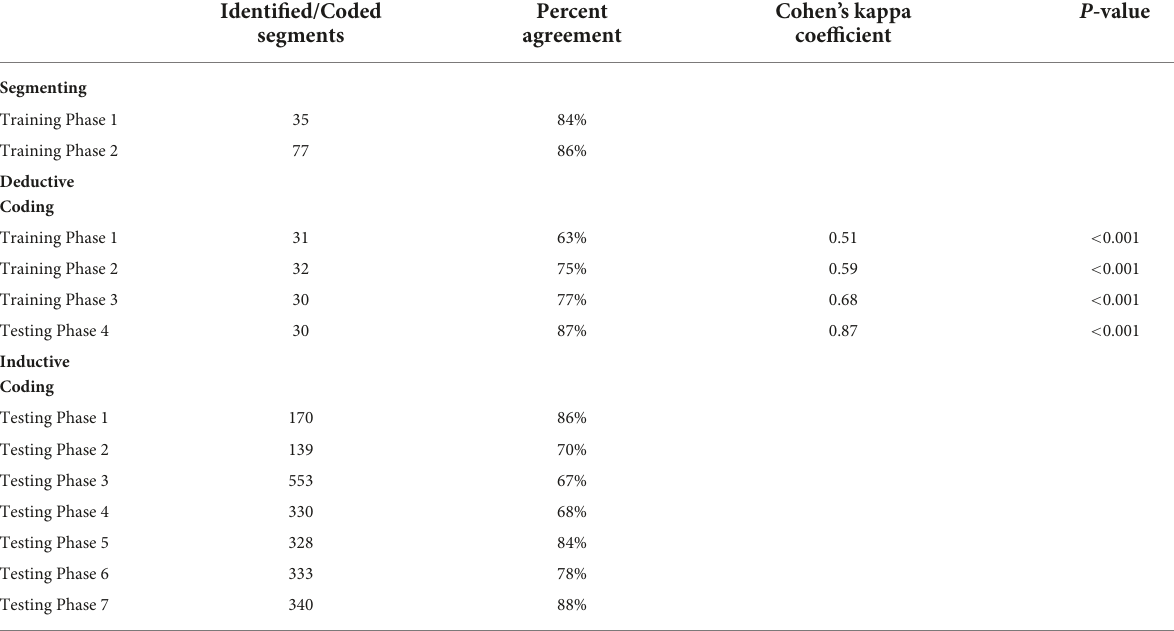
TABLE 1 Results of reliability crossing training/testing